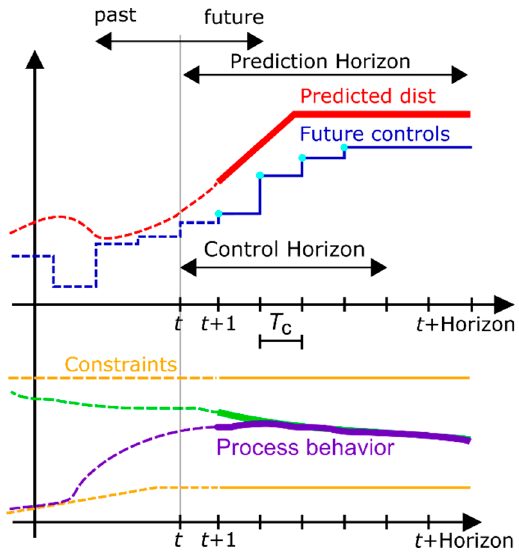
Figure 5. Basic concepts of MPC strategy. Graphical interpretation of the prediction horizon, control horizon and period, disturbance prediction.